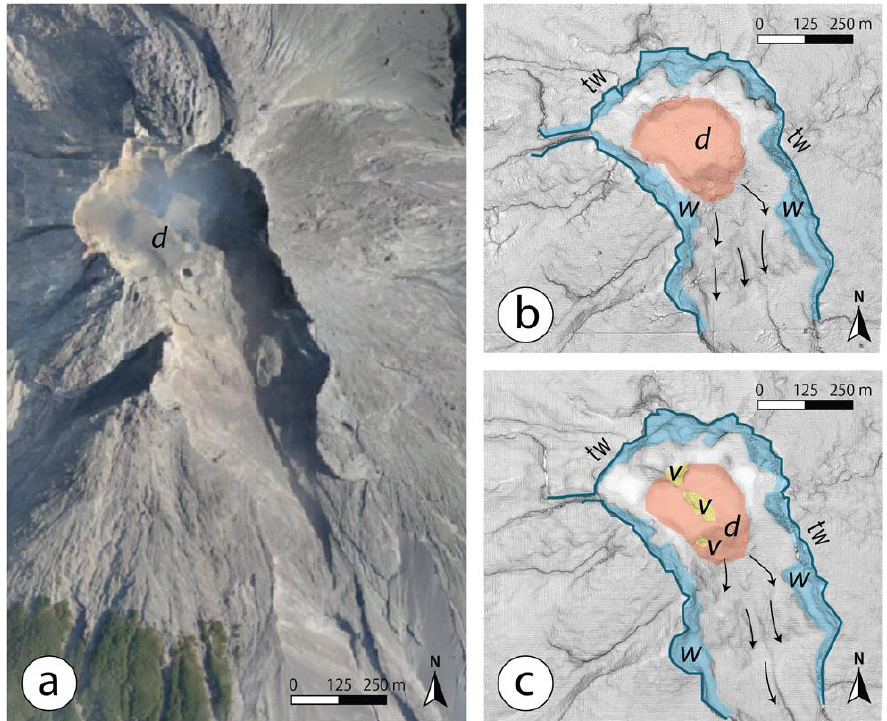
Figure 2. Dome of Merapi Volcano in 2012 and 2014: ( a ) orthophotograph constructed from UAV imagery in October 2014; ( b ) surface map of the dome in 2012 from LiDAR and ( c ) in 2014 from UAV-SfM-MVS. The captions are (d) dome in transparent red; (v) vent in transparent yellow; (tw) top of the wall and it corresponds to the blue line; (w) wall and it corresponds to the transparent